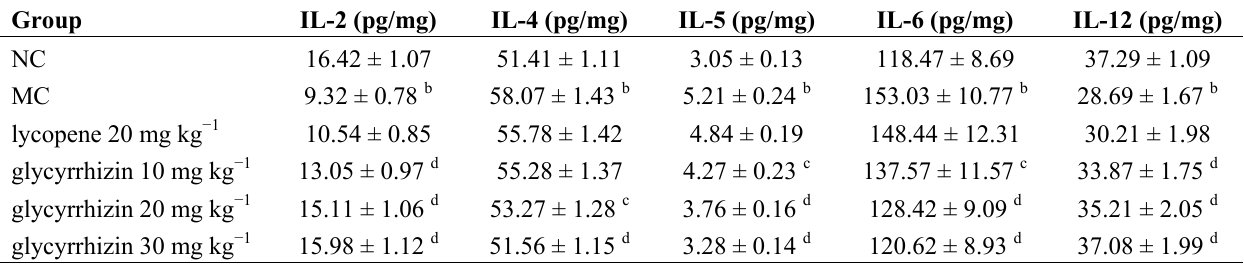
Table 3. Effect of glycyrrhizin treatment on blood IL-2, IL-4, IL-5, IL-6 and IL-12 levels. Group IL-2 (pg/mg) IL-4